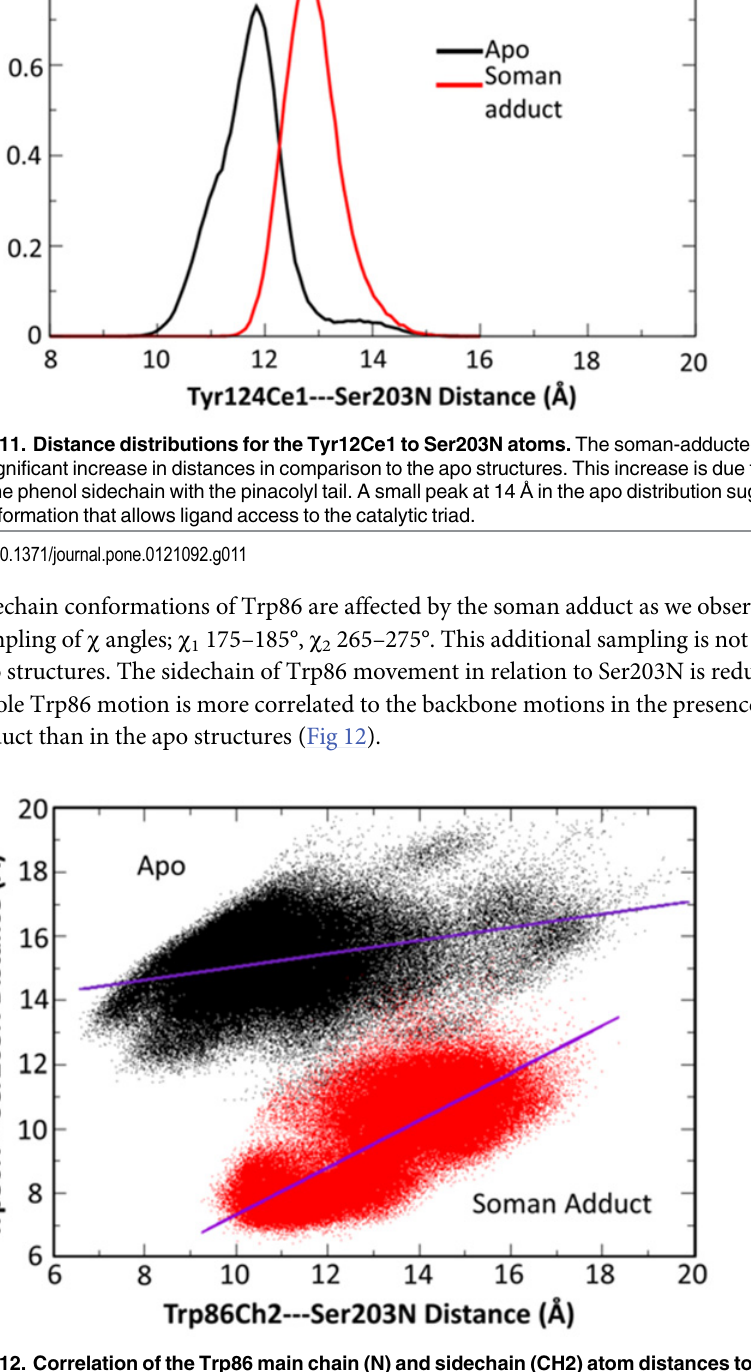
Fig 12. Correlation of the Trp86 main chain (N) and sidechain (CH2) atom distances to Ser203 (N). The high correlation suggests that the soman adduct has attenuated the sidechain motion of Trp86 and therefore directly influences the structure and dynamics of the Omega Loop and the swing gate to the back door